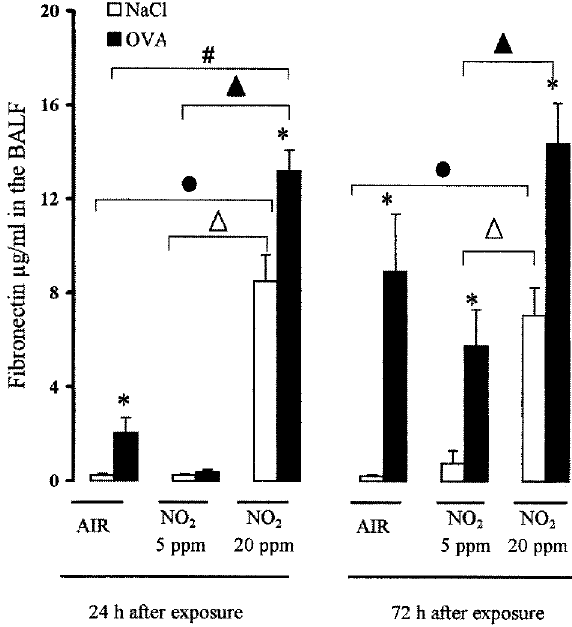
FIG. 2. BALF fibronectin content after short exposure to NO 2 . At day 14, immunized mice were challenged i.n. with saline ( h ) or OVA ( j ) and were exposed to 5 or 20ppm NO 2 or to air for 3h. At days 15 (24h) and 17 (72h) after exposure, mice were sacrificed. Fibronectin levels were evaluated in the BALF by ELISA. Data are expressed as the mean ± SEM. * p £ 0.05, OVA-challenged mice compared with their saline control; # p £ 0.05, OVA-air group compared with the NO 2 - OVA group (5 or 20ppm); d p £ 0.05, saline-air group compared with the NO 2 -saline group (5 or 20ppm); m p £ 0.05, 5ppm NO 2 -OVA group compared with the 20ppm NO 2 -OVA group; n p £ 0.05, 5ppm NO 2 -saline group compared with the 20ppm NO 2 -saline group.